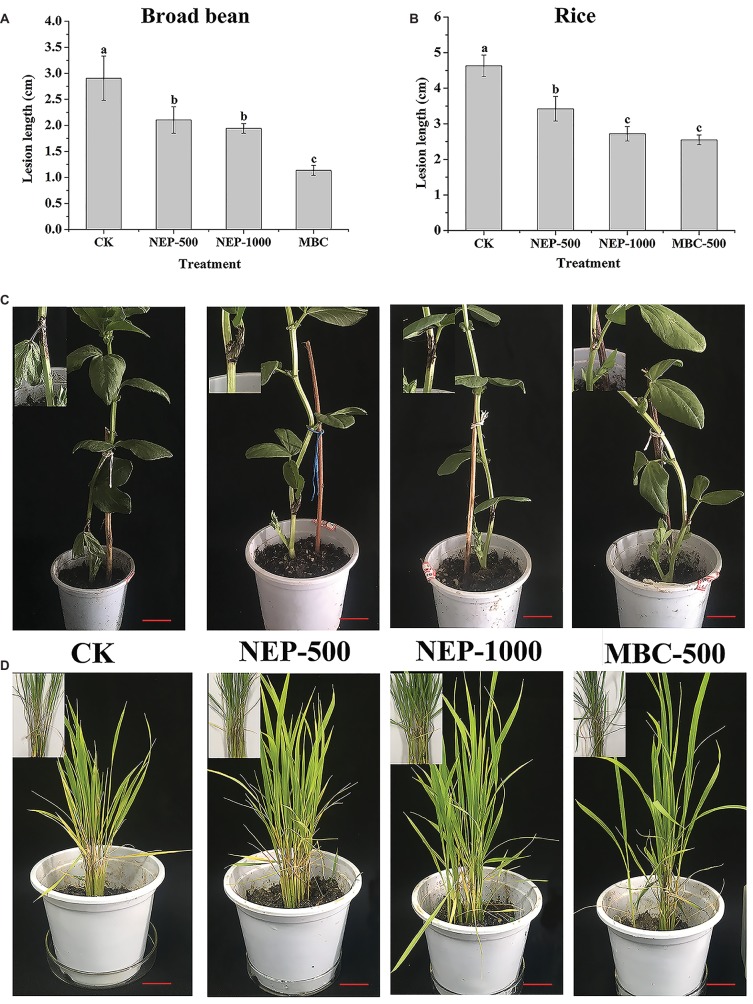
The lesion length and morphology of the plants infected by R. solani in pot experiments. (A) The lesion length of the broad bean plants; (B) the lesion length of the rice plants; (C) the morphology of the broad bean plants; and (D) the morphology of the rice plants. Insert: the disease area of the host plants. NEP500, 500 μg/ml of NEP-1; NEP1000, 1,000 μg/ml of NEP-1; MBC, 500 μg/ml of carbendazim; and CK was the blank control. Scale bar: 2.5 cm.